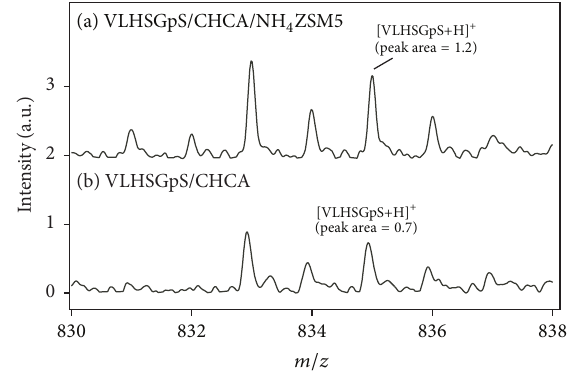
Figure 4: Mass spectra of phosphorylated peptide VLSGpS mea- sured with (a) CHCA/NH 4 ZSM5 and (b) CHCA